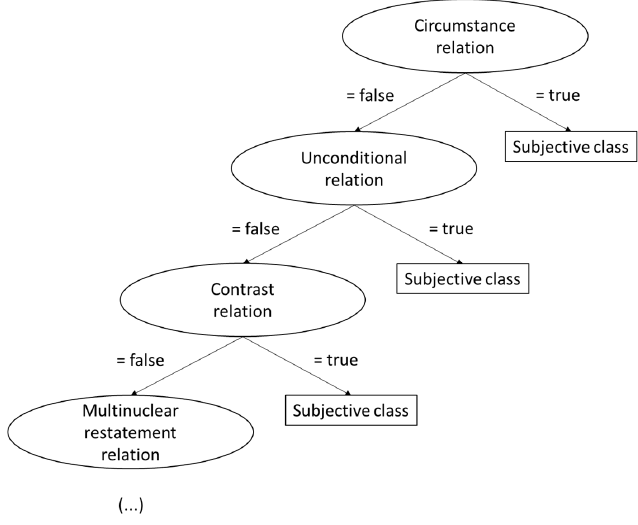
Figure 3. Part of the decision tree learned by J48 using all the features.